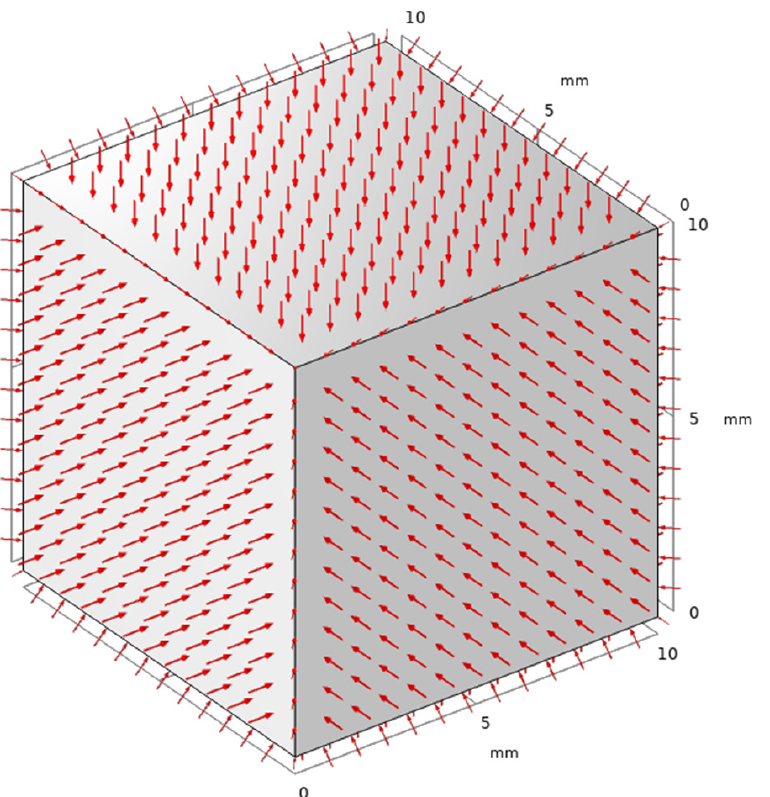
Figure 1. True triaxial stress test force diagram.